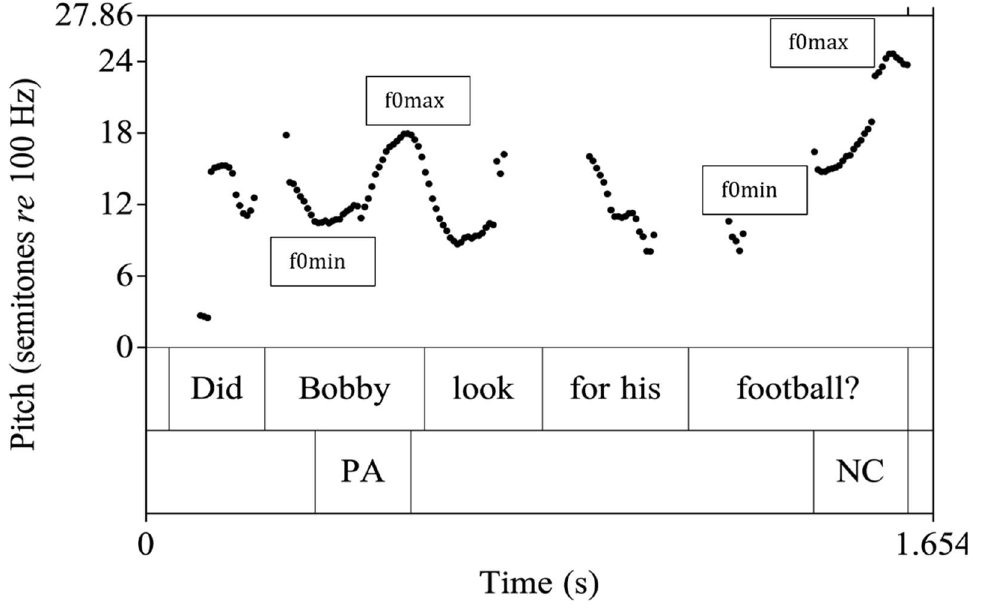
Figure 2. Example of labeling of pitch accent (PA) and nuclear contour (NC).